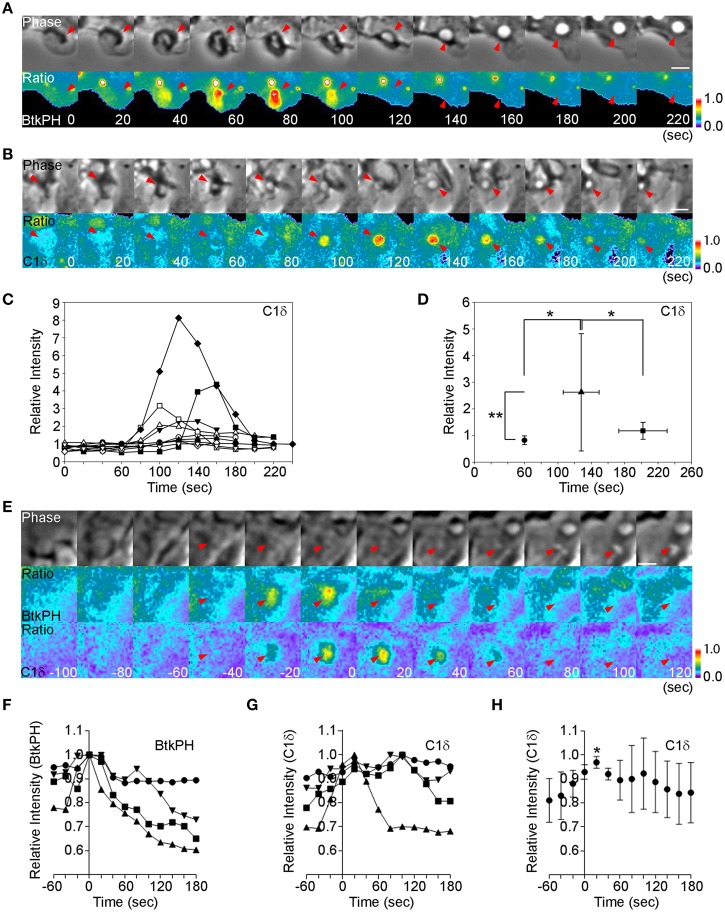
The PIP3 spike precedes DAG generation. (A) BMM expressing CFP and YFP-BtkPH, a probe for PIP3, were imaged during M-CSF-stimulated macropinocytosis. t = 0 and 60 s mark the beginning and end of ruffle closure, respectively. Ratio images show strong YFP-BtkPH recruitment to the macropinocytic cup at t = 80 s. Bar: 5 μm. (B) BMM expressing CFP and the DAG probe C1δ-YFP were imaged during M-CSF-stimulated macropinocytosis, as described in (A). Ratio images show C1δ-YFP recruitment at t = +100 s, which continued another 80 s. Bar: 5 μm. (C) Macropinosome-tracking analysis identified sequences in which ruffle closure occurred in 60 s (t = 60 s marks the end of ruffle closure, as determined by phase-contrast microscopy). The DAG signals of those sequences were compared by plotting of Rmac/Rcell as a relative intensity of C1δ-YFP. Different symbols distinguish individual sequences. * <0.05. ** <0.01. (D) Plot of average Rmac/Rcell at the end of ruffle closure (•), the peak of the signal (▴), and the end of cup closure (■). Signal intensities at the peak were significantly higher than those at the end of ruffle closure and the end of cup closure, suggesting that DAG levels peak during cup closure and slightly later than the PIP3 spike. (E) BMM expressing BtkPH-mTFP, C1δ-YFP, and mCherry were imaged during M-CSF-stimulated macropinocytosis. t = 0 s marks the peak of BtkPH-mTFP/mCherry ratios in the macropinocytic cup. C1δ–YFP/mCherry ratios indicate maximal DAG generation in the macropinocytic cup at t = +20 s. Bar: 2.5 μm. (F,G) Plots of Rmac as a relative fraction of maximal intensity ratios for BtkPH-mTFP (F) and C1δ–YFP (G) on macropinosomes (n = 4). Maximal BtkPH-mTFP/mCherry ratio values were aligned at t = 0 s. (H) Data for C1δ–YFP/mCherry ratios, aligned by setting the peaks of BtkPH-mTFP/mCherry ratio values in the same cells as t = 0 s. The C1δ–YFP/mCherry ratio values at t = 20 s were significantly greater than the values at t = 0 s. *p < 0.005.